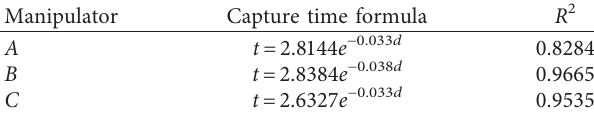
Table 2: Capture time formula.